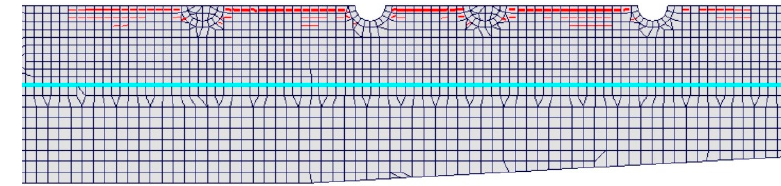
Figure 6. Detail of the crack opening along the sleeper axis in the numerical model.